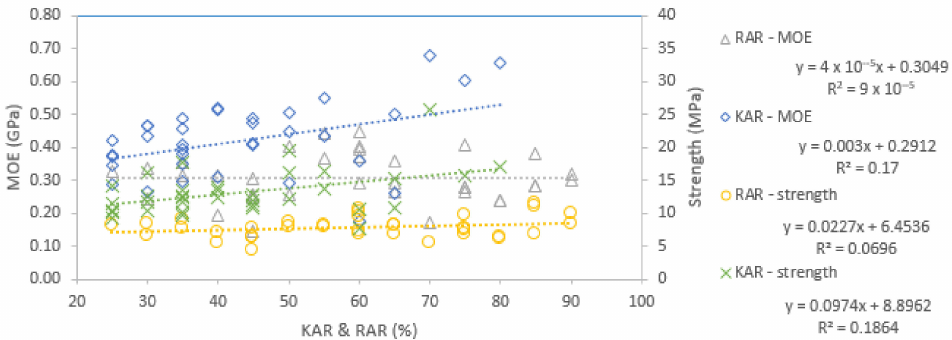
Figure 20. KAR and RAR vs. CPerpG MOE and